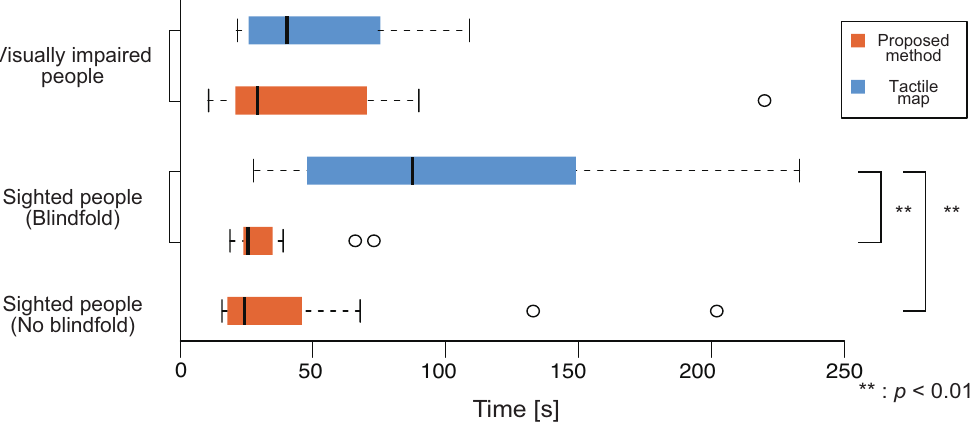
Figure 9. Time taken to determine the direction: 1 Sighted subjects-The average time using the proposed method was shorter than that for the tactile map. The proposed method took less time with the second blindfold. 2 Visually impaired subjects-There was no significant difference in the time between the tactile map and the proposed